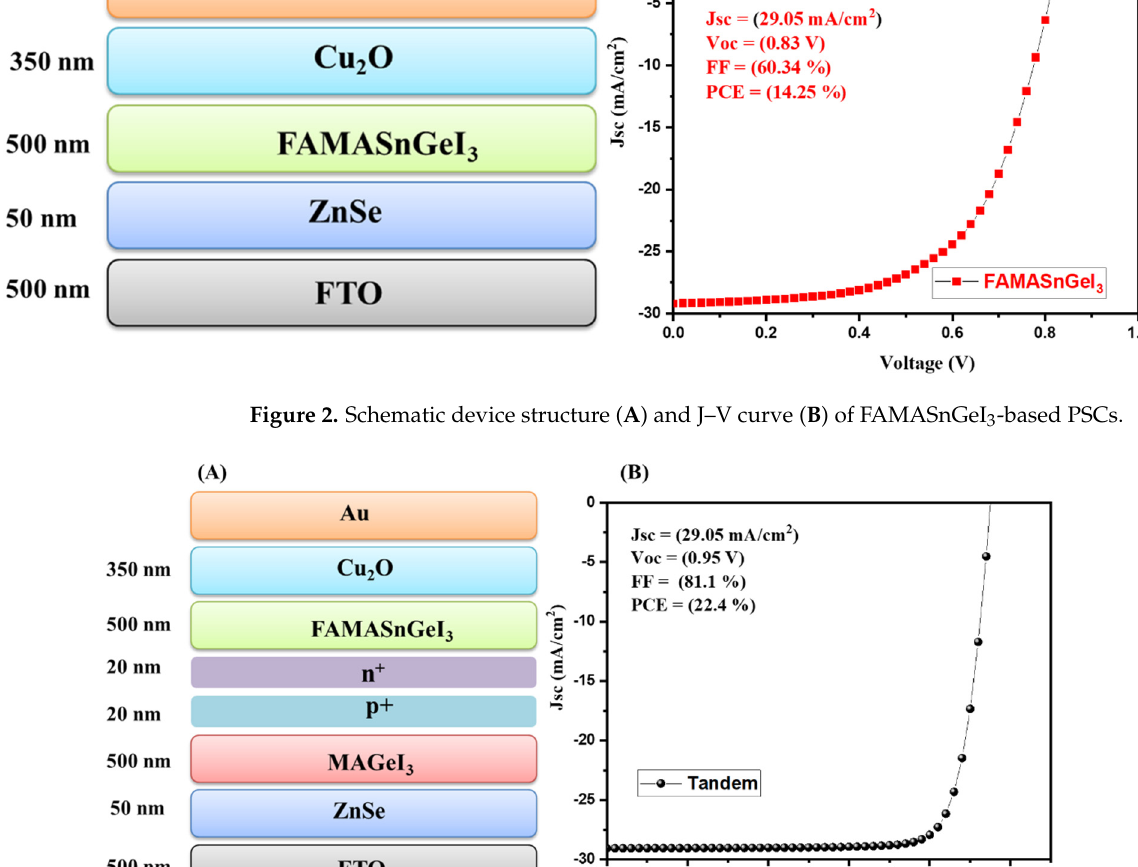
Figure 2. Schematic device structure ( A ) and J–V curve ( B ) of FAMASnGeI 3 -based PSCs.